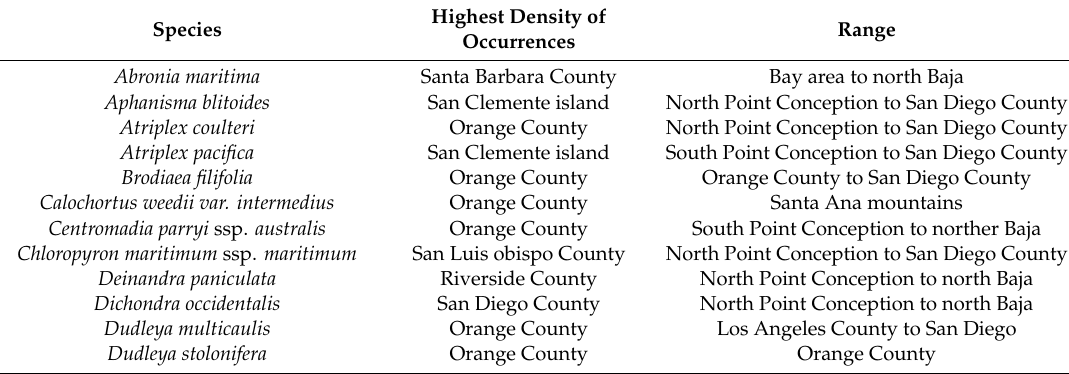
Table A3. Species with ranges that have the NCC Reserve and Orange County as their